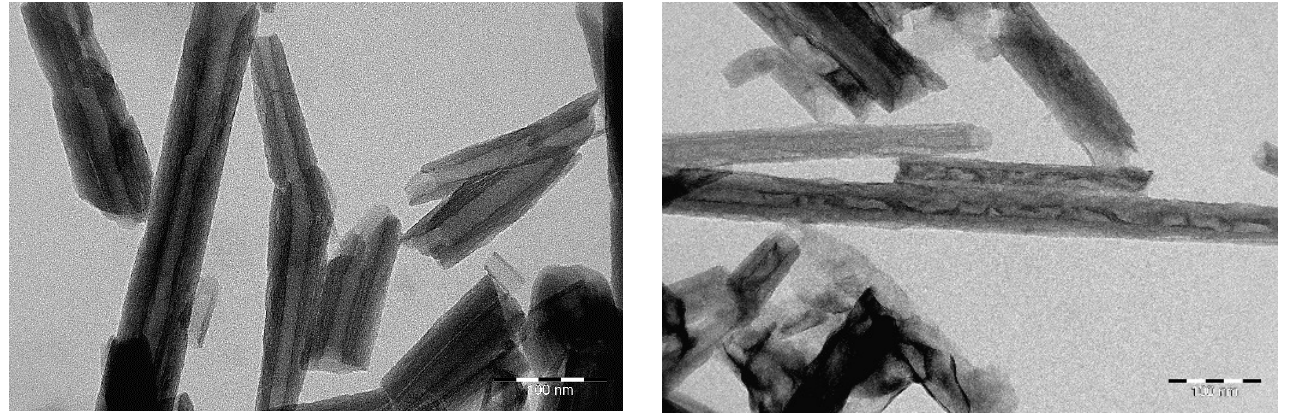
Figure 1. Morphology and microstructure of the applied nanoparticles. Table 1. The characteristics of NFAs.